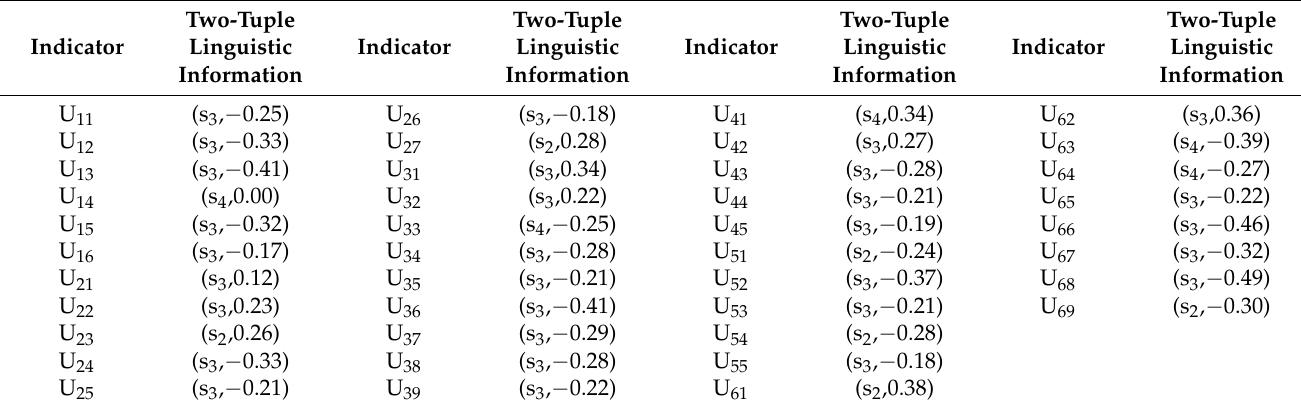
Table 3. Summary of Two-Tuple Linguistic Information of two-level indicators.